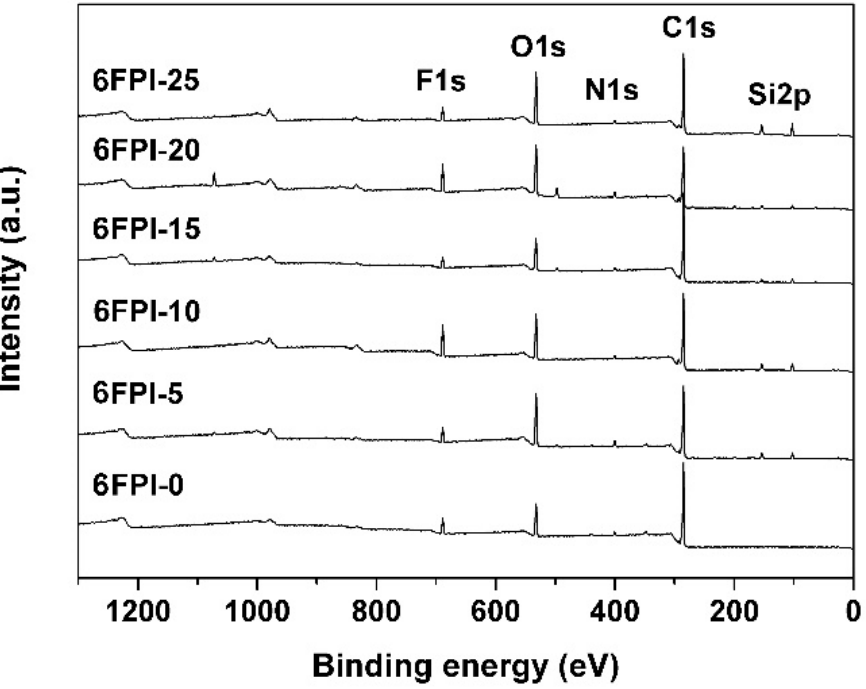
Figure 6. XPS spectra of 6FPI-POSS composite films.